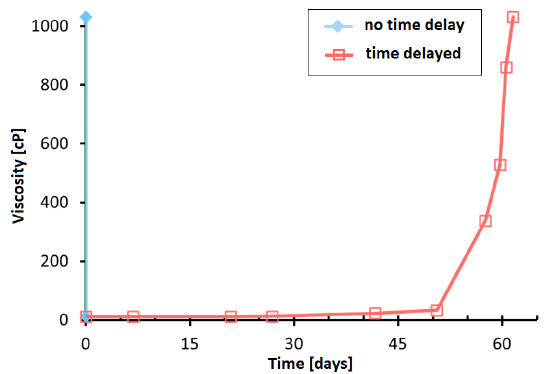
Figure 2. System with delayed gelation based on Texas A&M technology [33] (adapted from a presentation by prof. Jenn-Tai Liang at an internal project